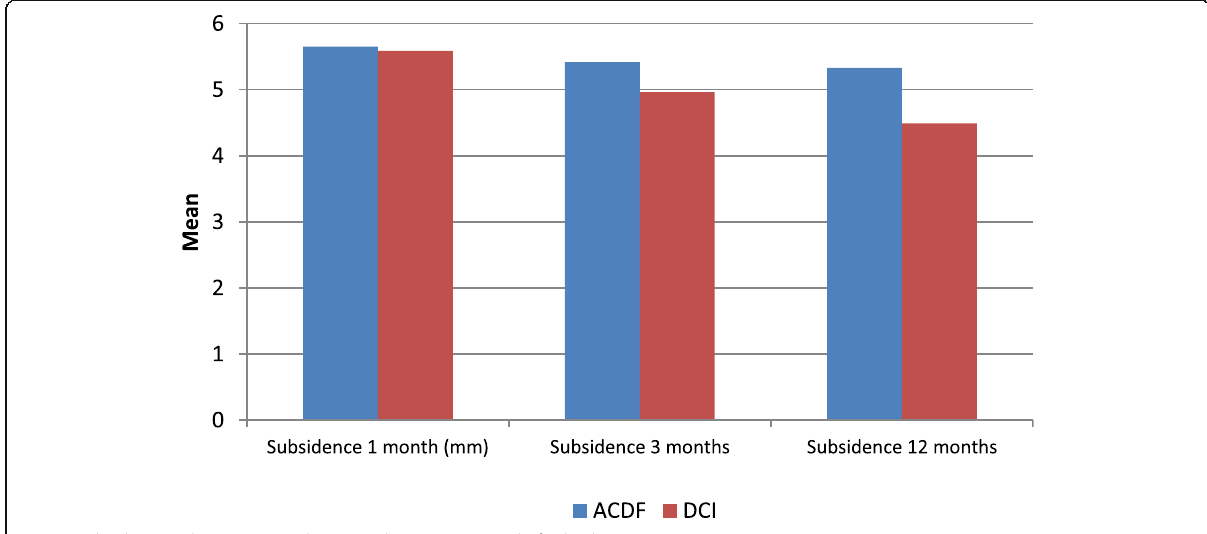
Fig. 4 Subsidence value at 1, 3, and 12 months postoperatively for both groups